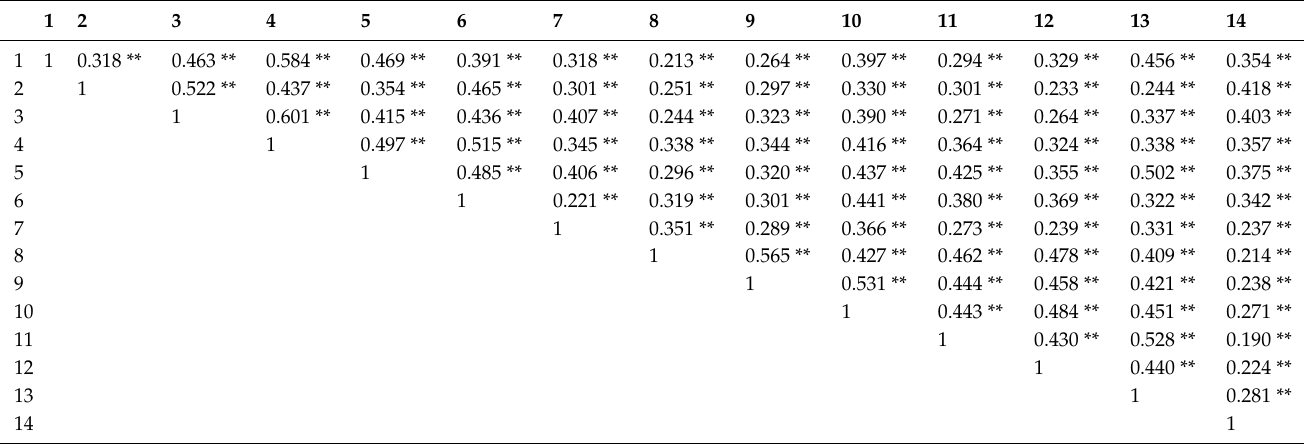
Table 5. Correlation matrix of the 14 items of the Stress and Anxiety